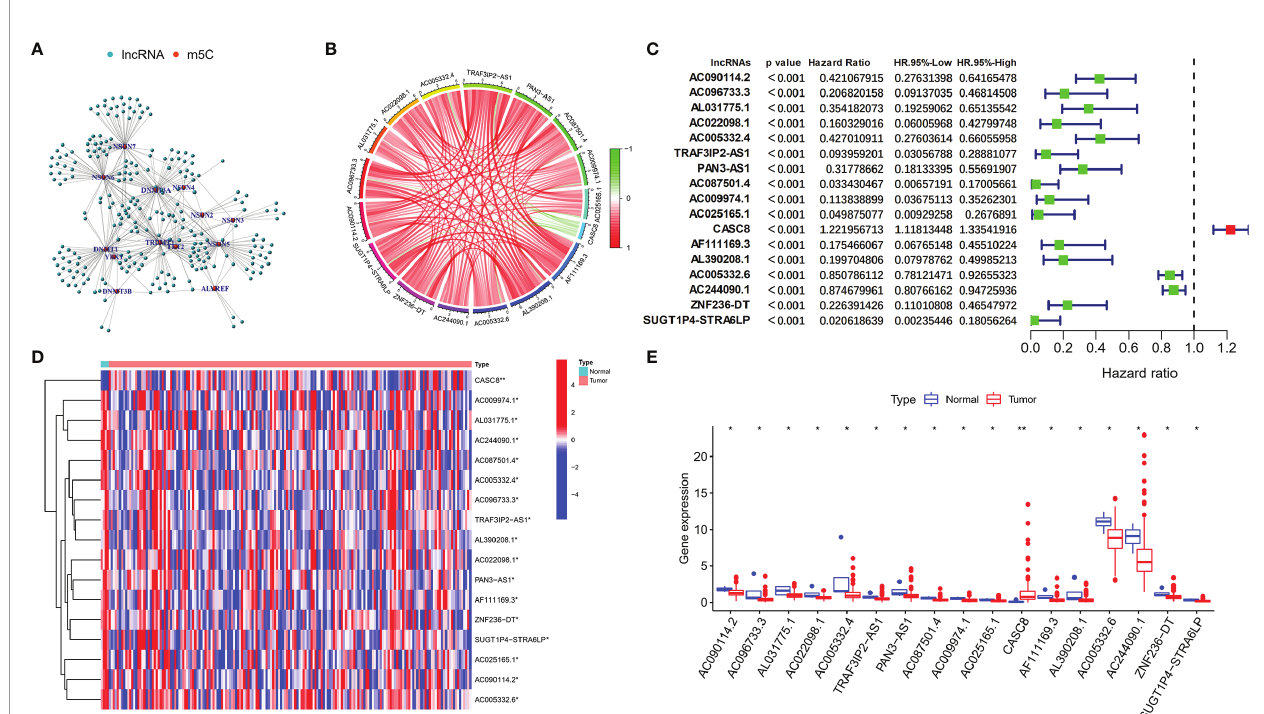
FIGURE 1 | Identi fi cation of m5C regulator-related lncRNAs with prognostic value in PDAC patients. (A) Co-expression relationship between m5C-related lncRNAs and m5C regulators. (B) Circos fi gure exhibited the expression correlation between the m5C-related lncRNAs with prognostic value (red line represents positive relationship and the green line represents negative relationship). (C) Forest plot showed the prognostic risk value of the 17 screened m5C-related lncRNAs via univariate Cox regression analysis. (D, E) Heatmap and scatter diagram indicated the different expression of m5C-related lncRNAs in normal and tumor tissues. * p < 0.05, ** p <